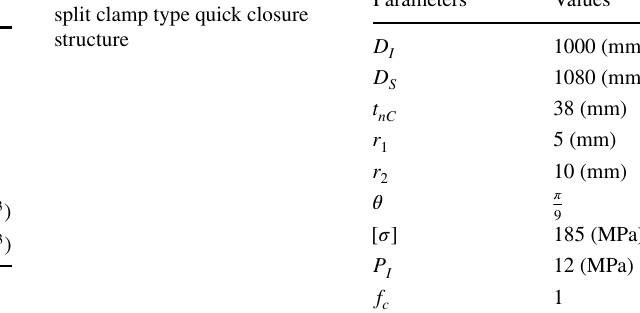
Table 13 Parameters of